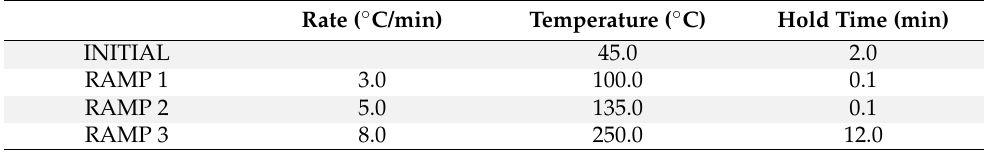
Table 1. Oven temperature program for